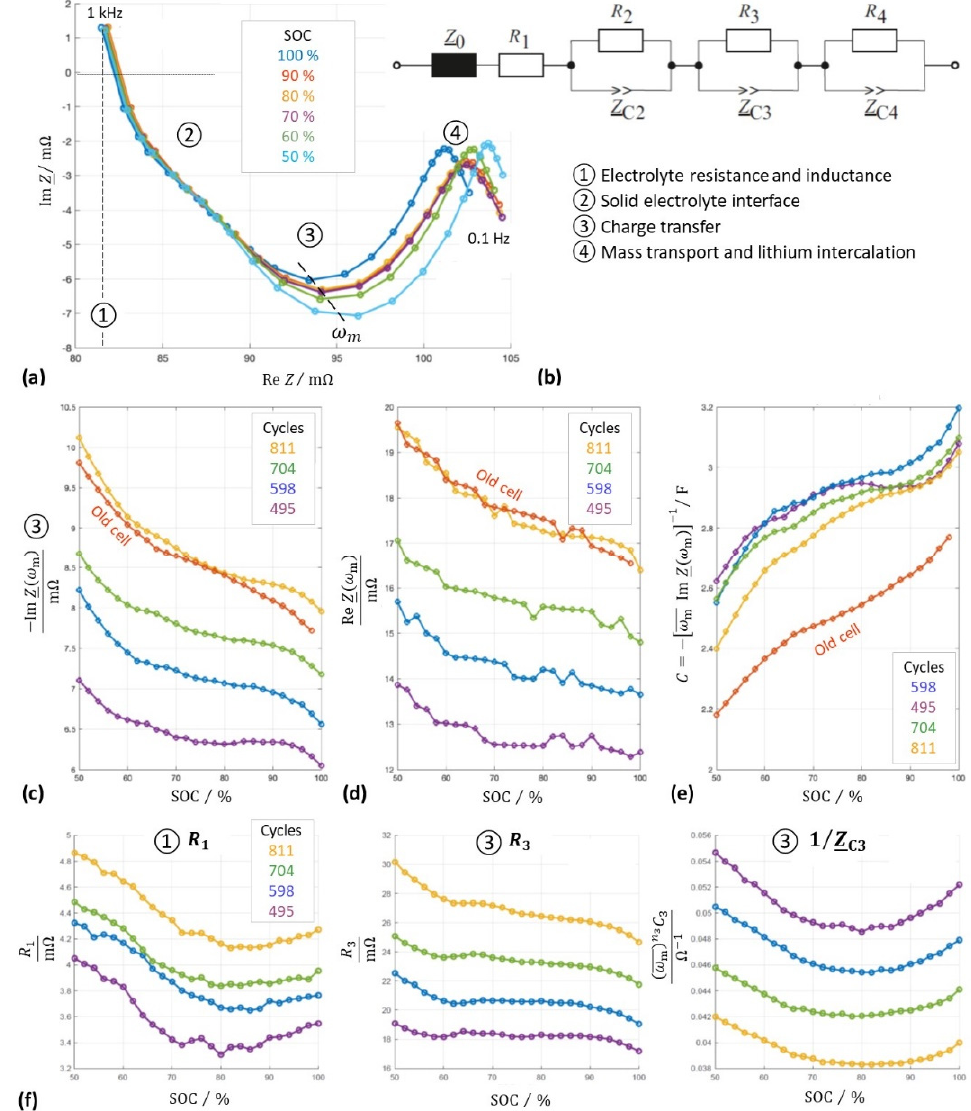
Figure 9. Frequency response of a lithium-ion battery (Panasonic 18650, LCO chemistry) during aging in a DOD 20 cycle test: ( a ) Nyquist plot: different SOC at the same SOH = 495 cycles in mathematical concentration, ( b ) equivalent circuit, ( c ) reactance, ( d ) resistance, and ( e ) capacitance at the mean minimum ω m of the charge-transfer semicircle 3 (cid:13) in the complex plane (1 kHz . . . 1 Hz). For comparison: a failure device of the same type from a DOD 100 test. ( f ) Nonlinear least squares fit results with respect to the equivalent circuit: R ohmic resistance, Z = (j ω ) n C is a constant phase element (lossy